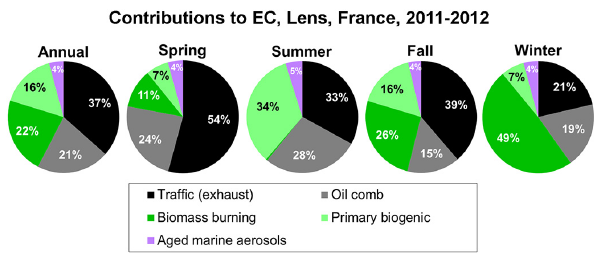
Fig. 8. Contributions of the identified sources in % to total EC mass concentration for the year 2011–2012, spring, summer, fall and win-